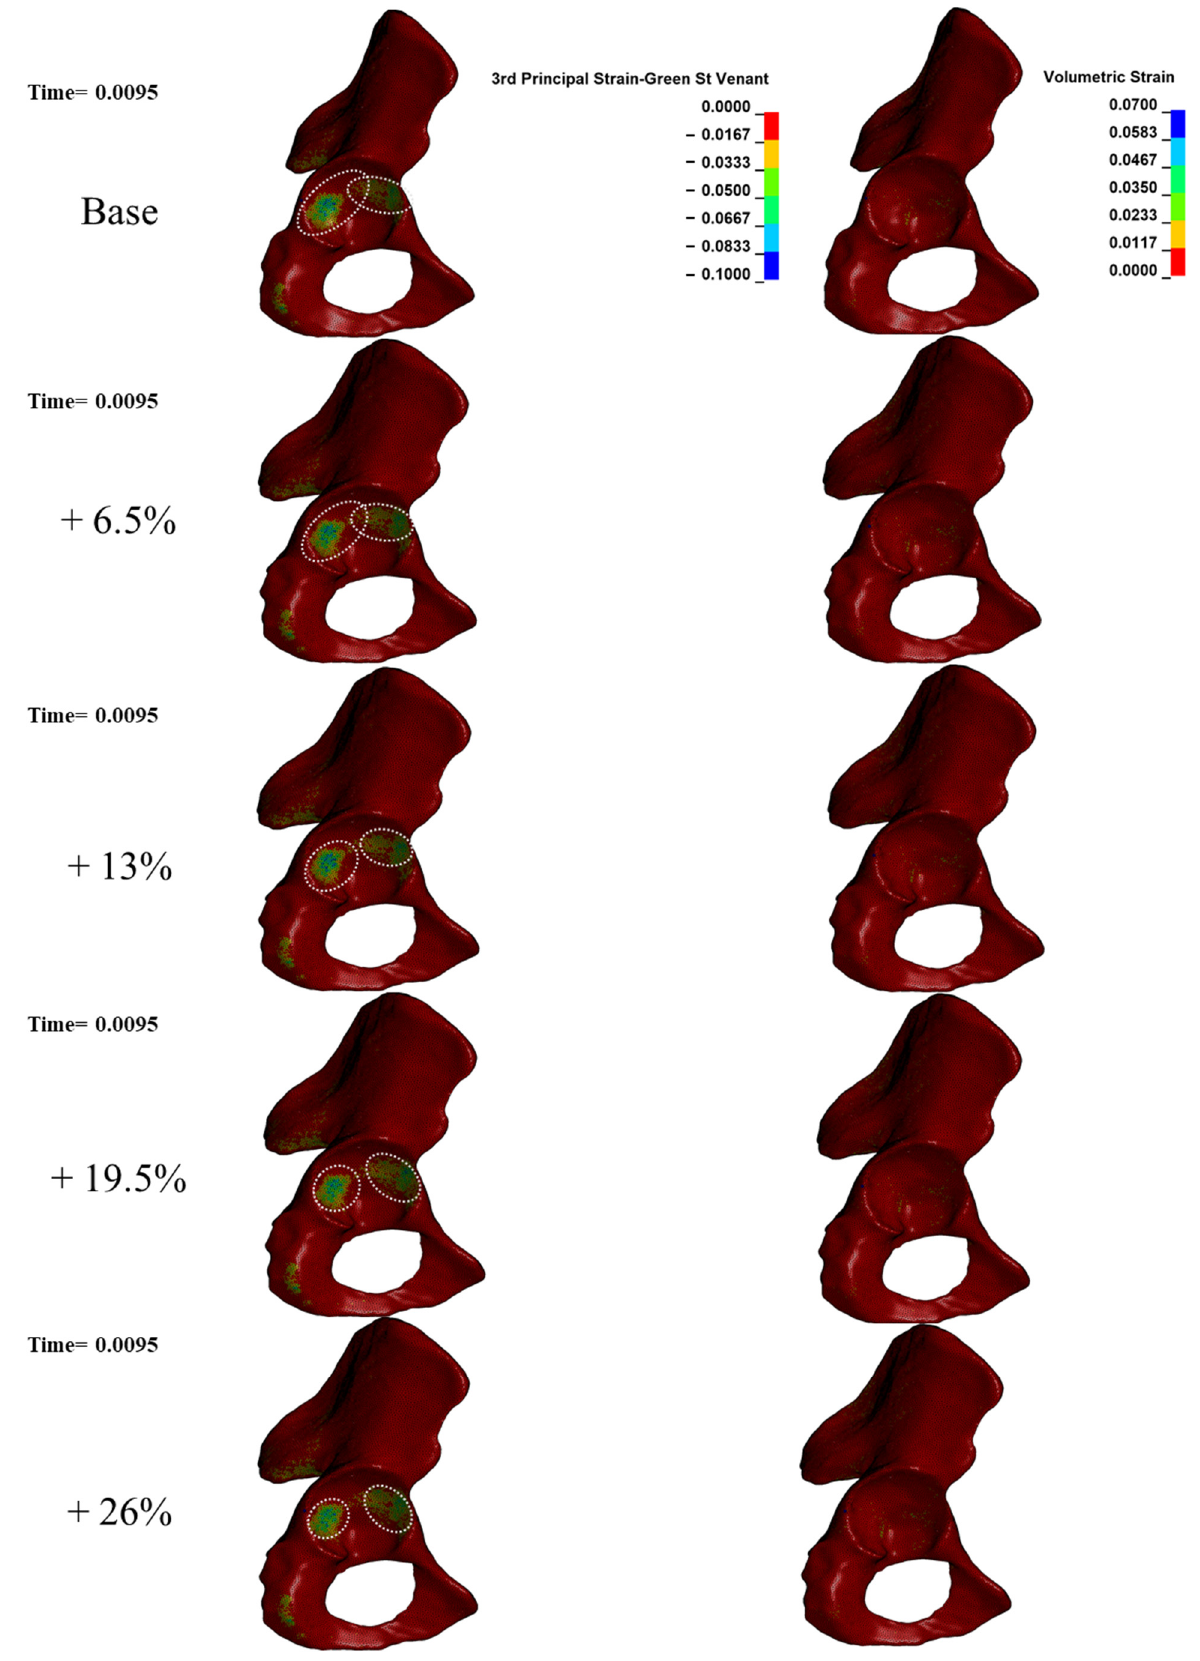
Figure 7. Effect of TST stiffness on the compressive ( left column ) and tensile bone failure ( right column ) within the pelvis.